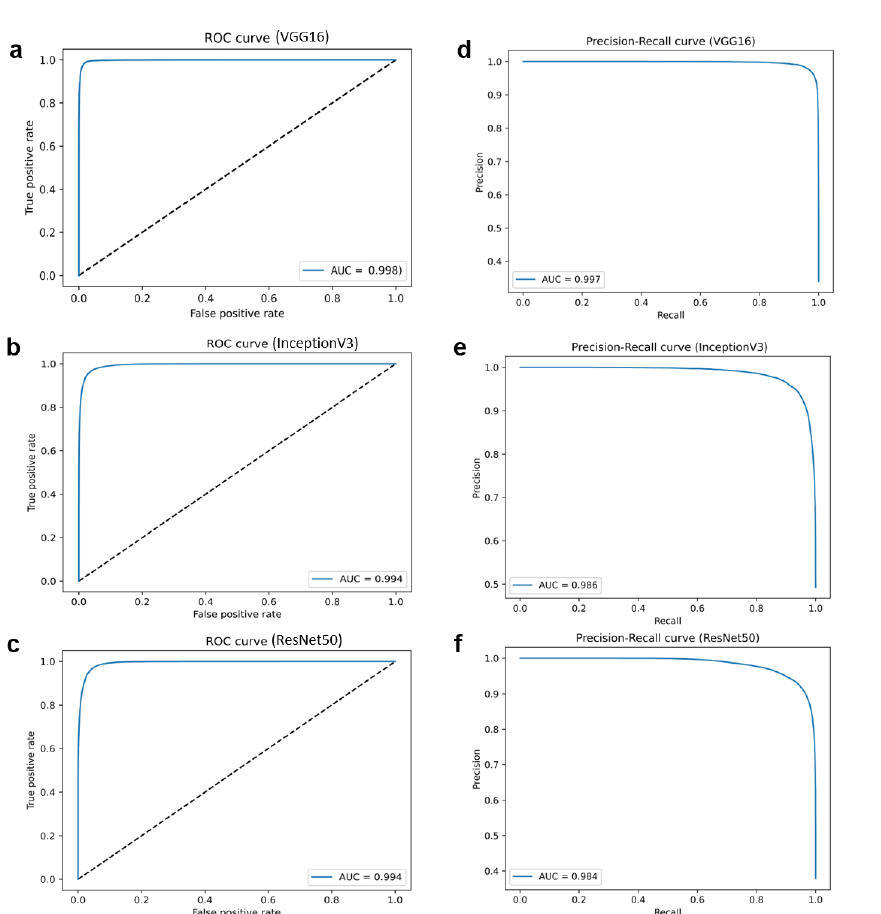
Figure 1. Results of Receiver Operating Curves (ROC) and AUC for VGG16 ( a ), InceptionV3 ( b ), and ResNet50 ( c ). Results of Precision–Recall curve (PRC) and AUC for VGG16 ( d ), InceptionV3 ( e ), and ResNet50 ( f